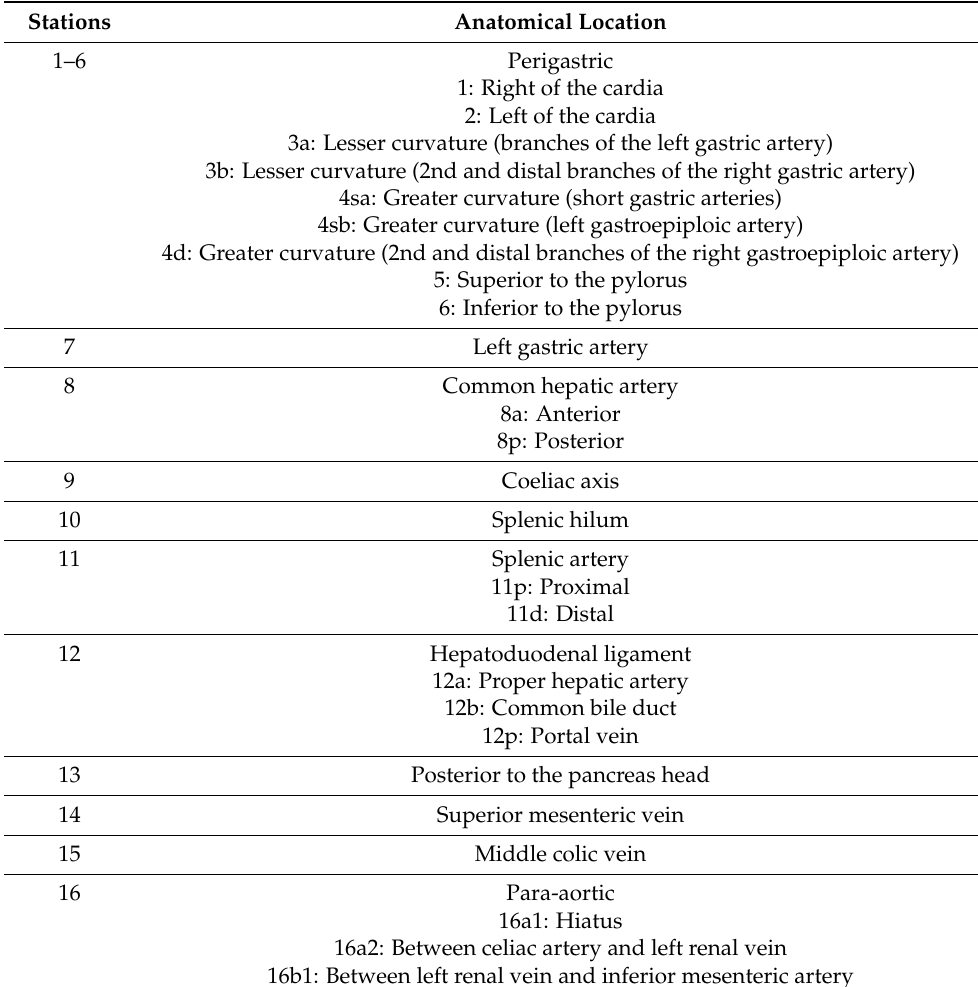
Table 2. Japanese Gastric Cancer Association Lymph Node